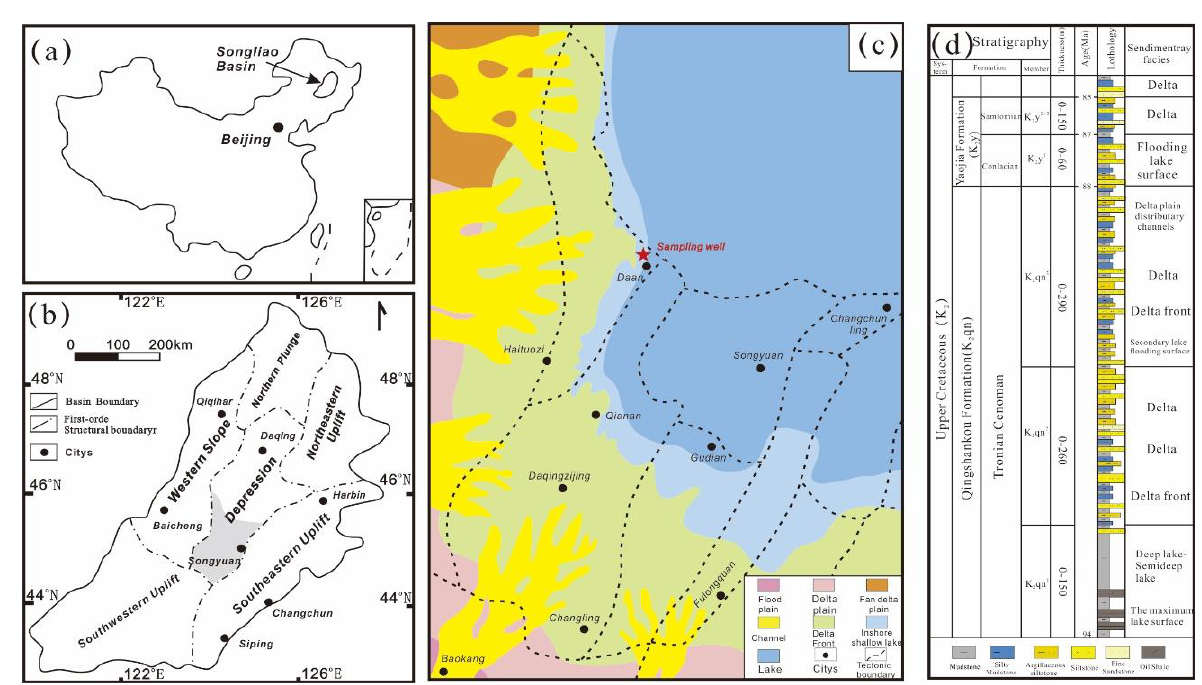
Figure 1. ( a ) Location of Songliao Basin; ( b ) Six tectonic units in the Songliao Basin; ( c ) The study area and depositional settings of K 2 qn in the Songliao Basin [9]. ( d ) Stratigraphic column and lithology of the Qingshankou Formation in Songliao Basin [10].